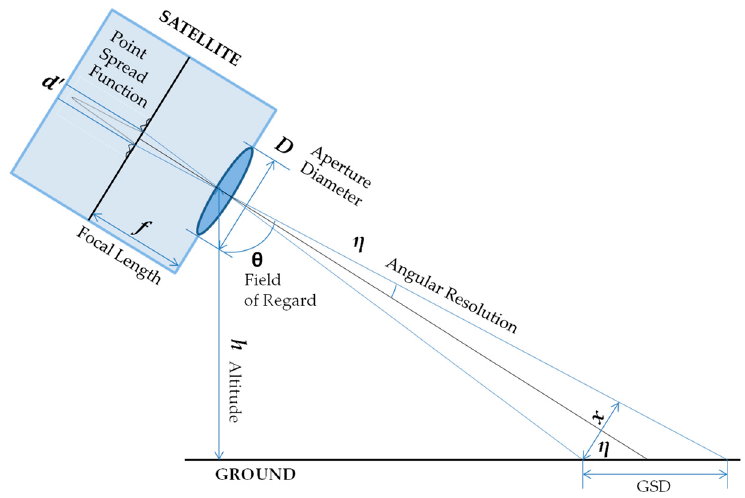
Figure 5. Optical relationship of ground sample distance (GSD) with other parameters (not to scale).